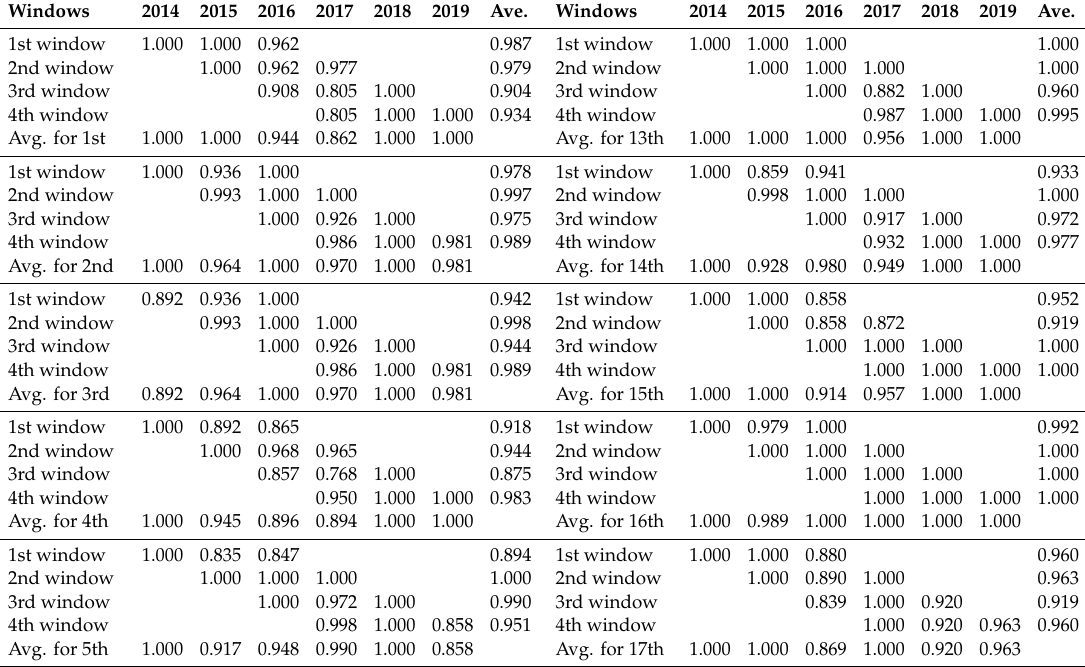
Table 5. Window analysis for FDH